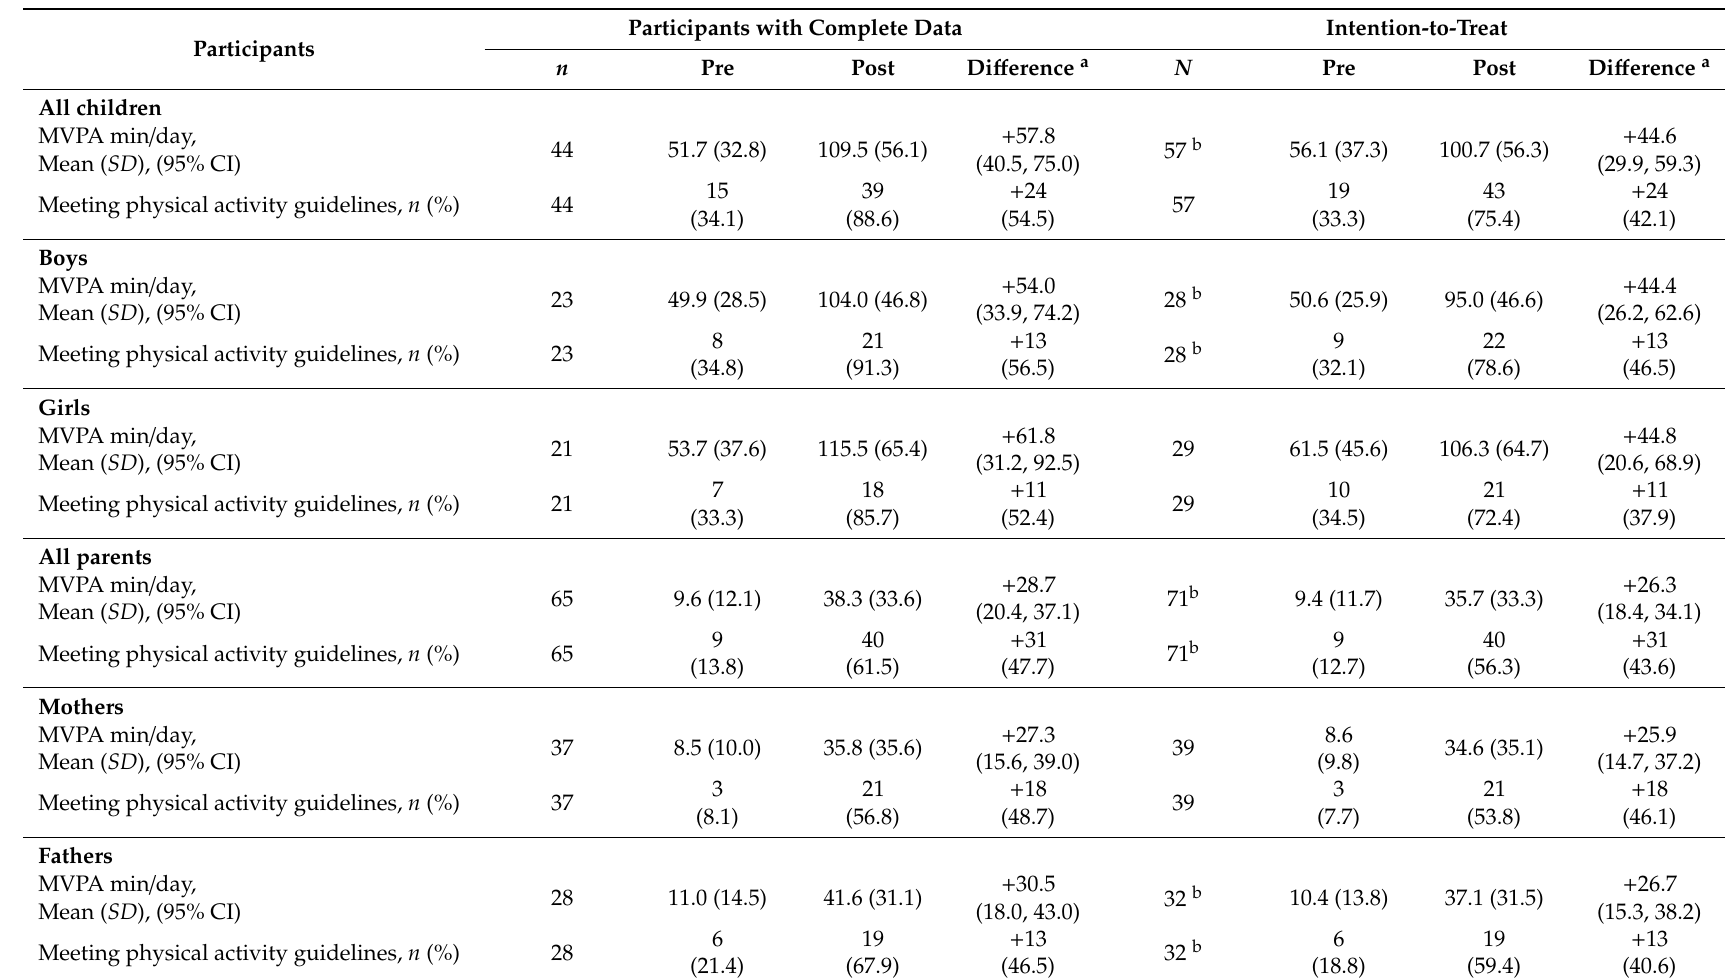
Table 3. Pre-post Intervention Physical Activity Changes in Children, Mothers and